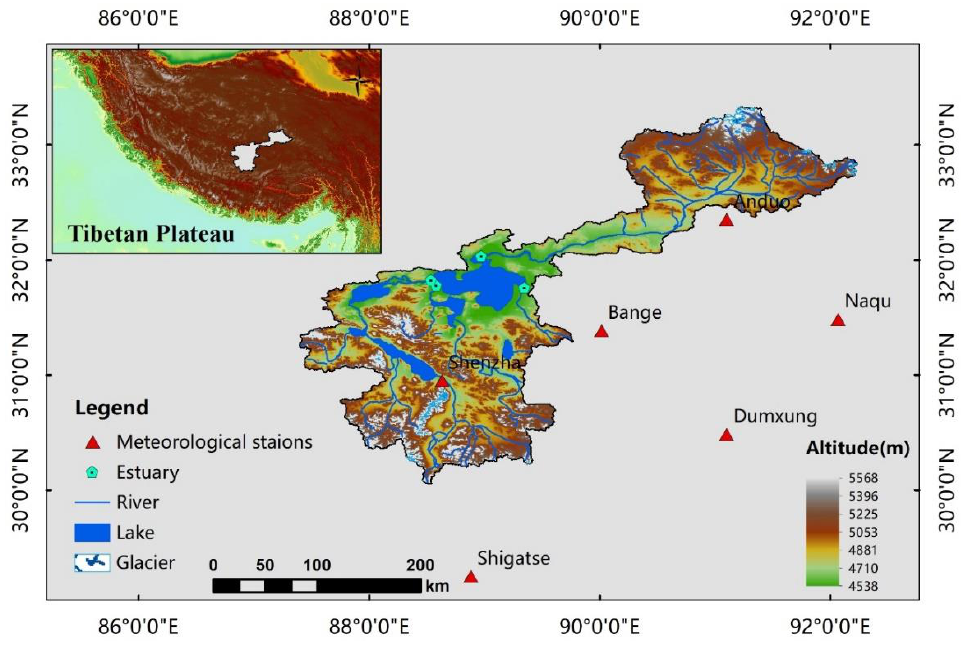
Figure 1. Overview of the Siling Co basin and the locations of meteorological stations.